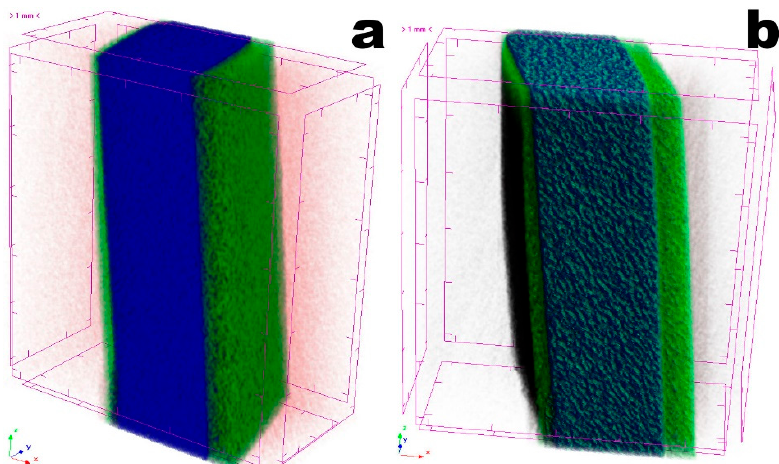
Figure 6. Images obtained by X-ray tomographic analyses of the bioluminescent/chromogenic hydrogel, being ( a ) a leaning surface view allowing us to observe the top side (right thicker surface in green), and ( b ) a leaning surface view allowing us to observe the bottom side (left thin surface in green). Due to its higher atomic density, the bio-polysaccharide matrix (in blue and green in